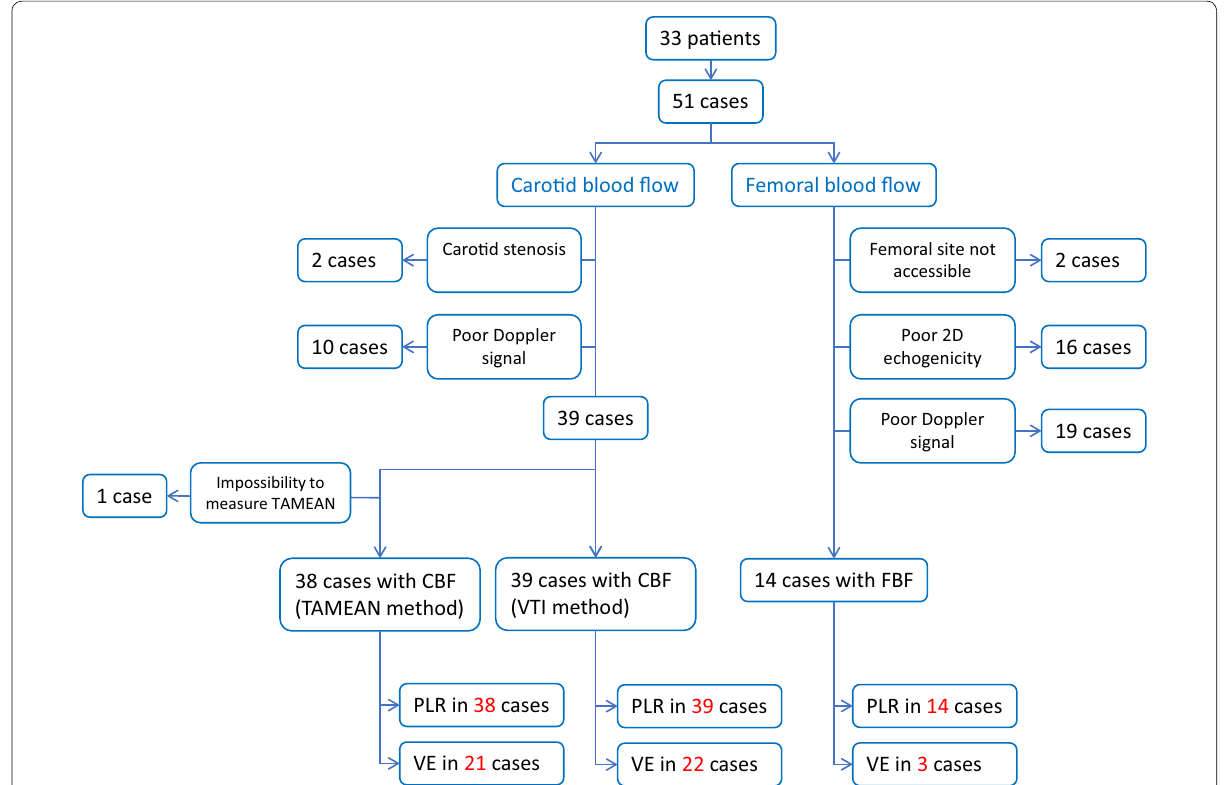
Fig. 2 Flowchart. CBF carotid blood flow, PLR passive leg raising, TAMEAN time average mean velocity, VE volume expansion, VTI velocity time integral